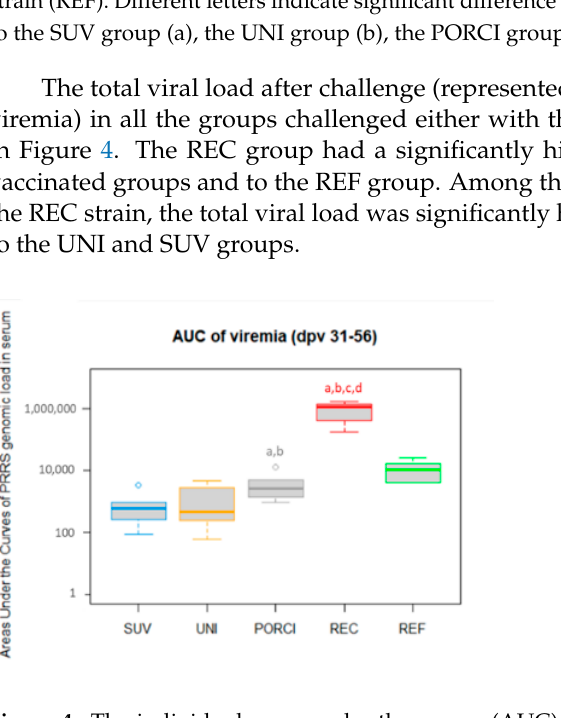
Figure 4. The individual areas under the curves (AUC) of viral loads quantified in serum from dpv 31 to 56 (post-challenge period). The SUV, UNI and PORCI groups were vaccinated with the vaccines Suvaxyn, Unistrain or Porcilis PRRS at day 0, and challenged at dpv 28. The REC and REF groups were unvaccinated. Different letters indicate significant difference obtained comparing the considered group to the SUV group (a), the UNI group (b), the PORCI group (c) or the REF group (d), with p <